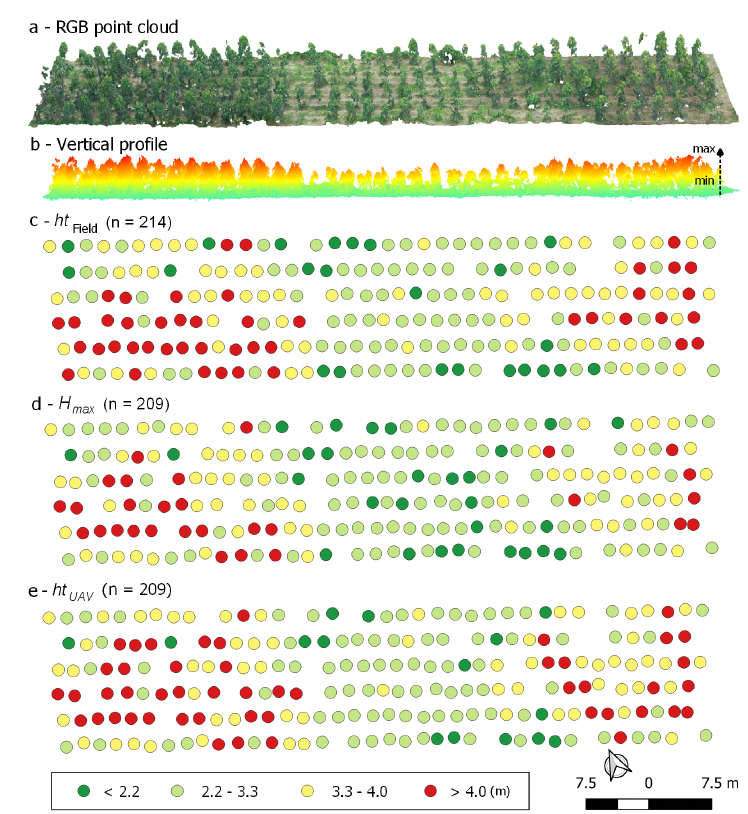
Figure 7. ( a ) RGB point cloud of a young Eucalyptus stand; ( b ) the associated vertical profile; and maps detailing the spatial distribution of tree height as ( c ) measured in the field ( ht Field ) and ( d , e ) estimated from UAV photogrammetry ( H max and ht UAV ,